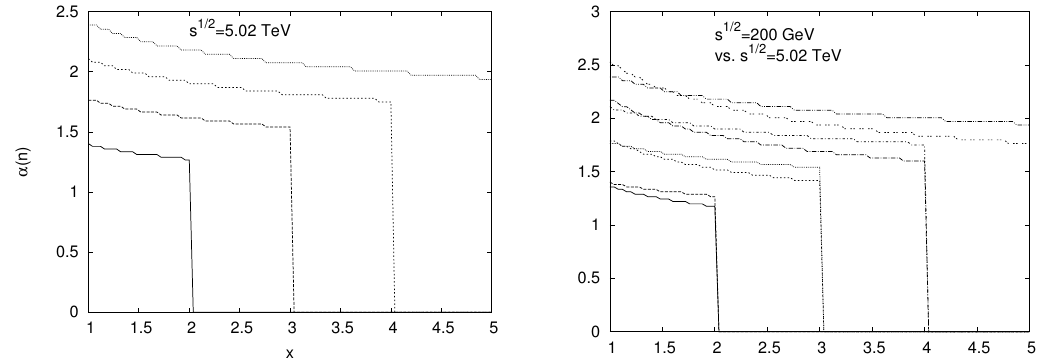
√ s = 5.02 TeV and comparison of